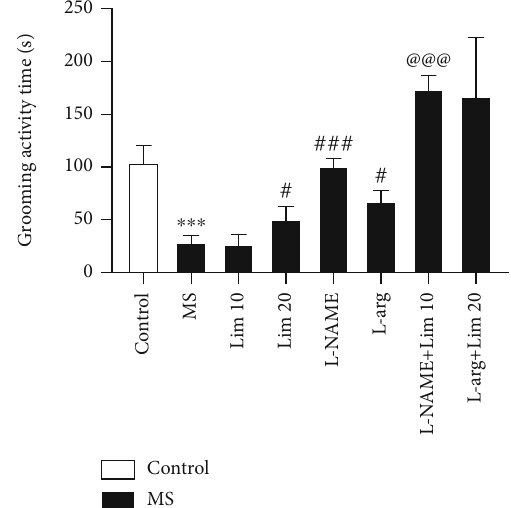
Figure 4: Grooming activity duration in the splash test. Values are presented as the mean ± S : E : M : from 8 animals and were analyzed by one-way ANOVA followed by Tukey ’ s post hoc test. ∗∗∗ P < 0 : 001 compared to the control group. # P < 0.05 and ### P < 0 : 001 compared to the MS group. @@@ P < 0 : 001 compared to the group that received limonene at a dose of 10 mg/kg. MS: maternal separation; Lim: limonene; L-arg: